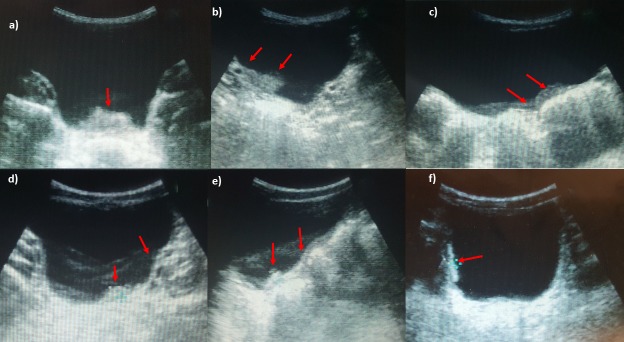
Ultrasonography images of urinary bladder of PSAC infected with S. haematobium.a) focal thickening of the bladder wall, longitudinal plane shows mass-like lesion (arrows); b) transverse plane image shows diffuse thickening of the bladder wall more evident in the right posterior wall; c) transverse plane image shows a focal heterogeneous echo of the bladder wall in absence of true thickening or mass-like lesions in the lumen; d) longitudinal plane shows a marked and diffuse thickening of the bladder left wall with a mass like lesion (arrow); e) image of diffuse and marked thickening of the bladder wall with pseudo-polyp lesion; f) focal thickening of the wall evident on the right wall and diffuse heterogeneity of bladder echo.